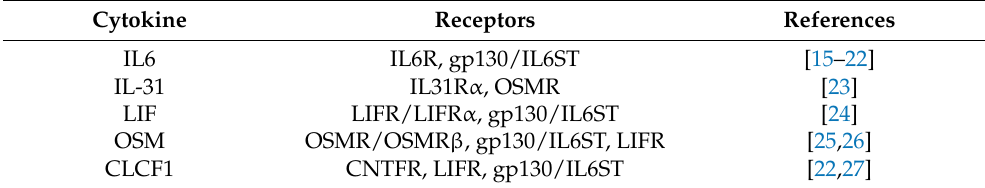
Table 1. Other IL6 family cytokines and components of the specific receptors associated with NSCLC. Cytokine